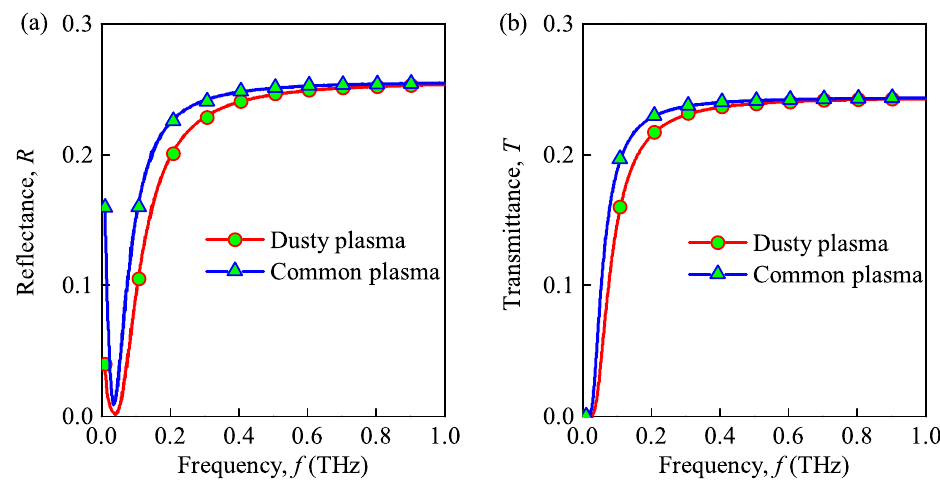
Figure 4. Reflectance ( a ) and transmittance versus wave ( b ) frequency under dusty plasma with ceramic substrate and common plasma with ceramic